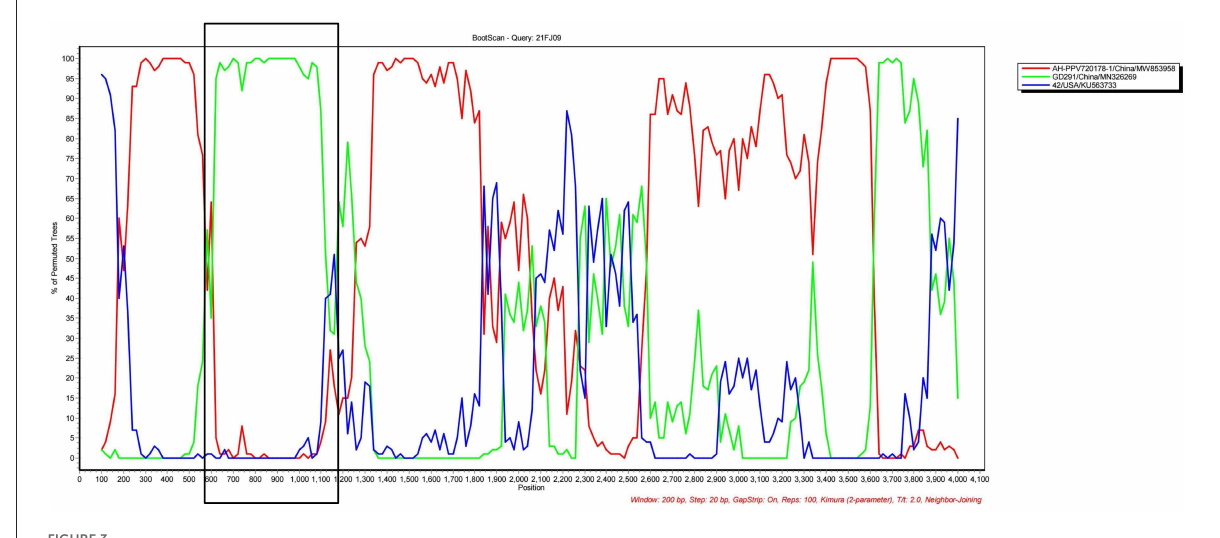
FIGURE3 SIMPLOT recombination analysis. Bootscanning analysis was performed using 21FJ09, GD291, AH-PPV720178-1, and 21FJ09 as query sequences, with a sliding window of 200 nt that moved in 20 nt